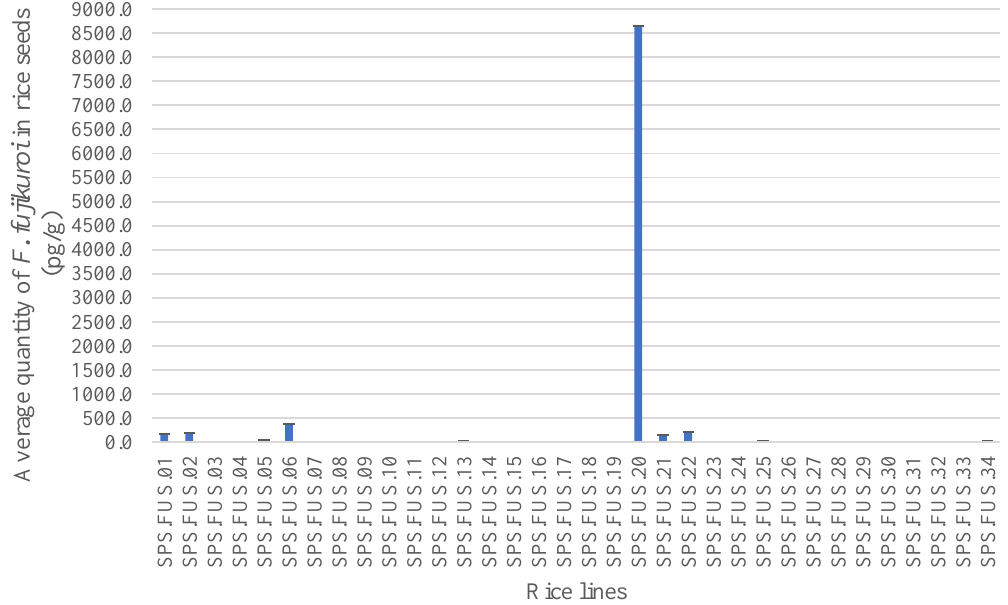
Figure 3. Average quantity of F. fujikuroi in the whole seed obtained by the detection of 34 rice lines with real-time PCR with TaqMan probe in triplicate. The values are the means ± standard deviations (ANOVA, Tukey test, p ≤ 0.05)